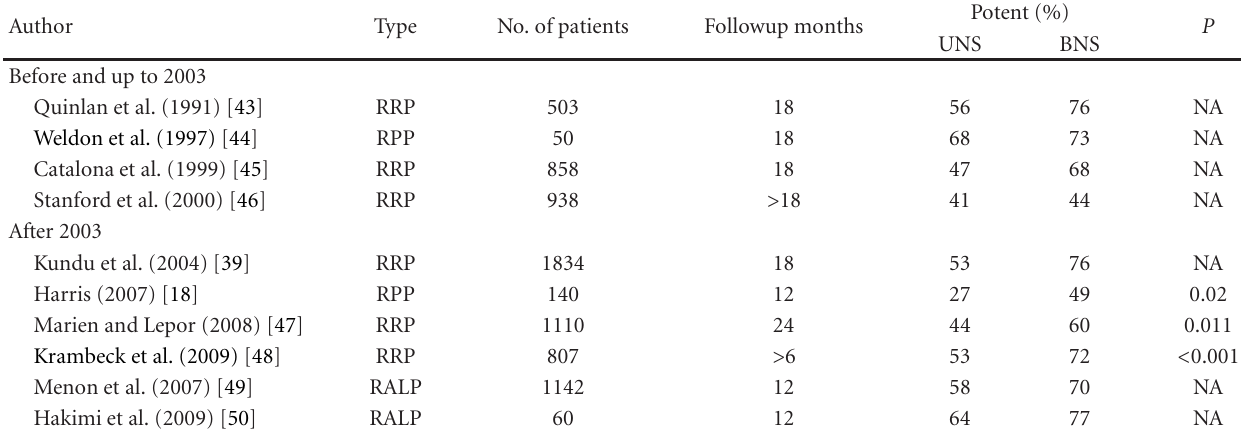
Table 1: E ff ect of nerve sparing in radical prostatectomy on sexual function